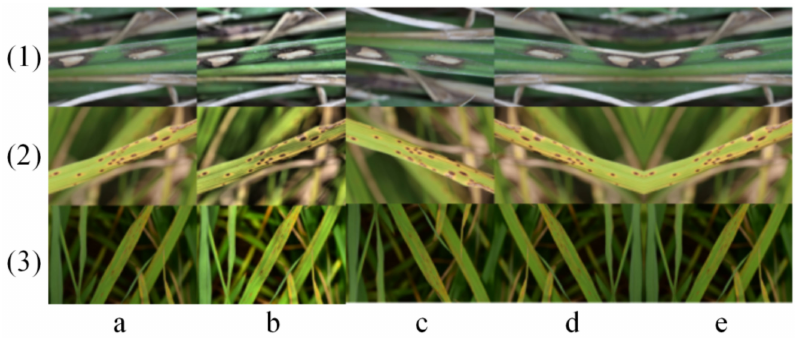
Figure 1. Disease image dataset. ( 1 ) is the image of stripe blight, ( 2 ) is the image of hoary leaf spot, ( 3 ) is the image of stripe disease, and ( a – e ) are image sharpening, histogram equalization, mirroring by X-axis, mirroring by Y-axis and original image,